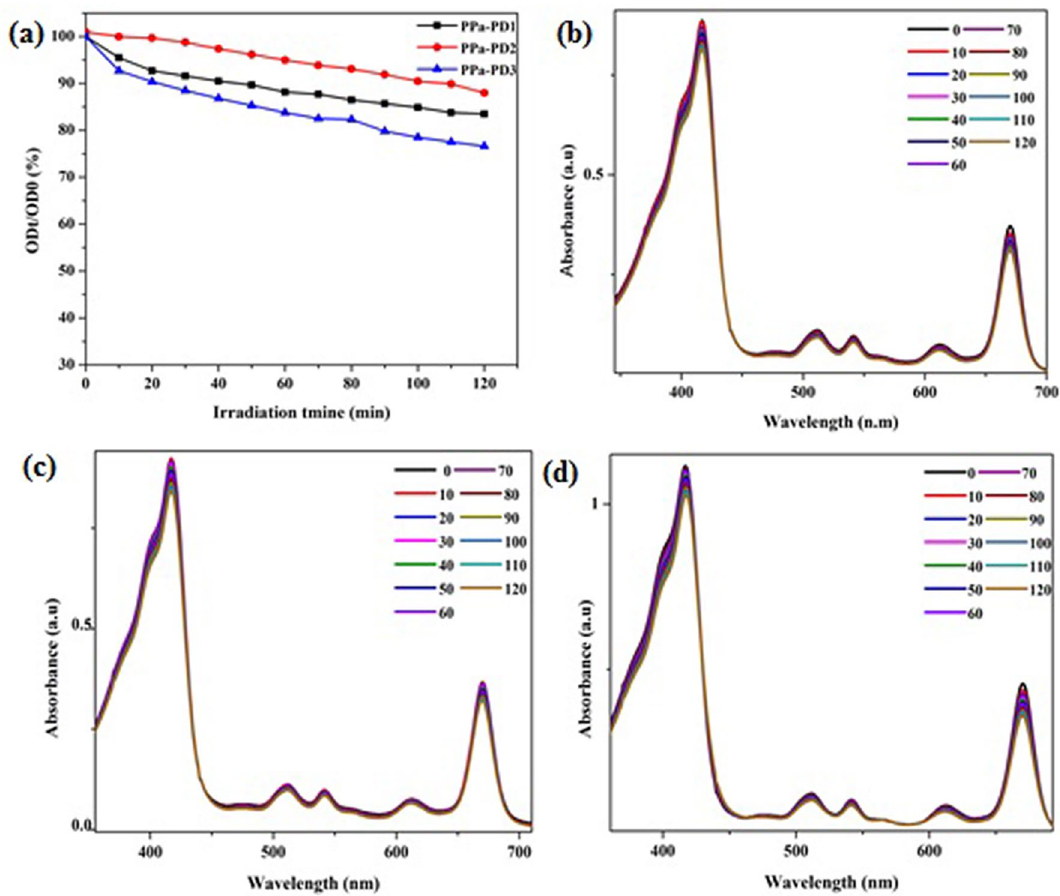
Figure 4. ( a ) Photostability of the conjugates in DMSO, ( b ) PPa-PD1, ( c ) PPa-PD2, ( d )